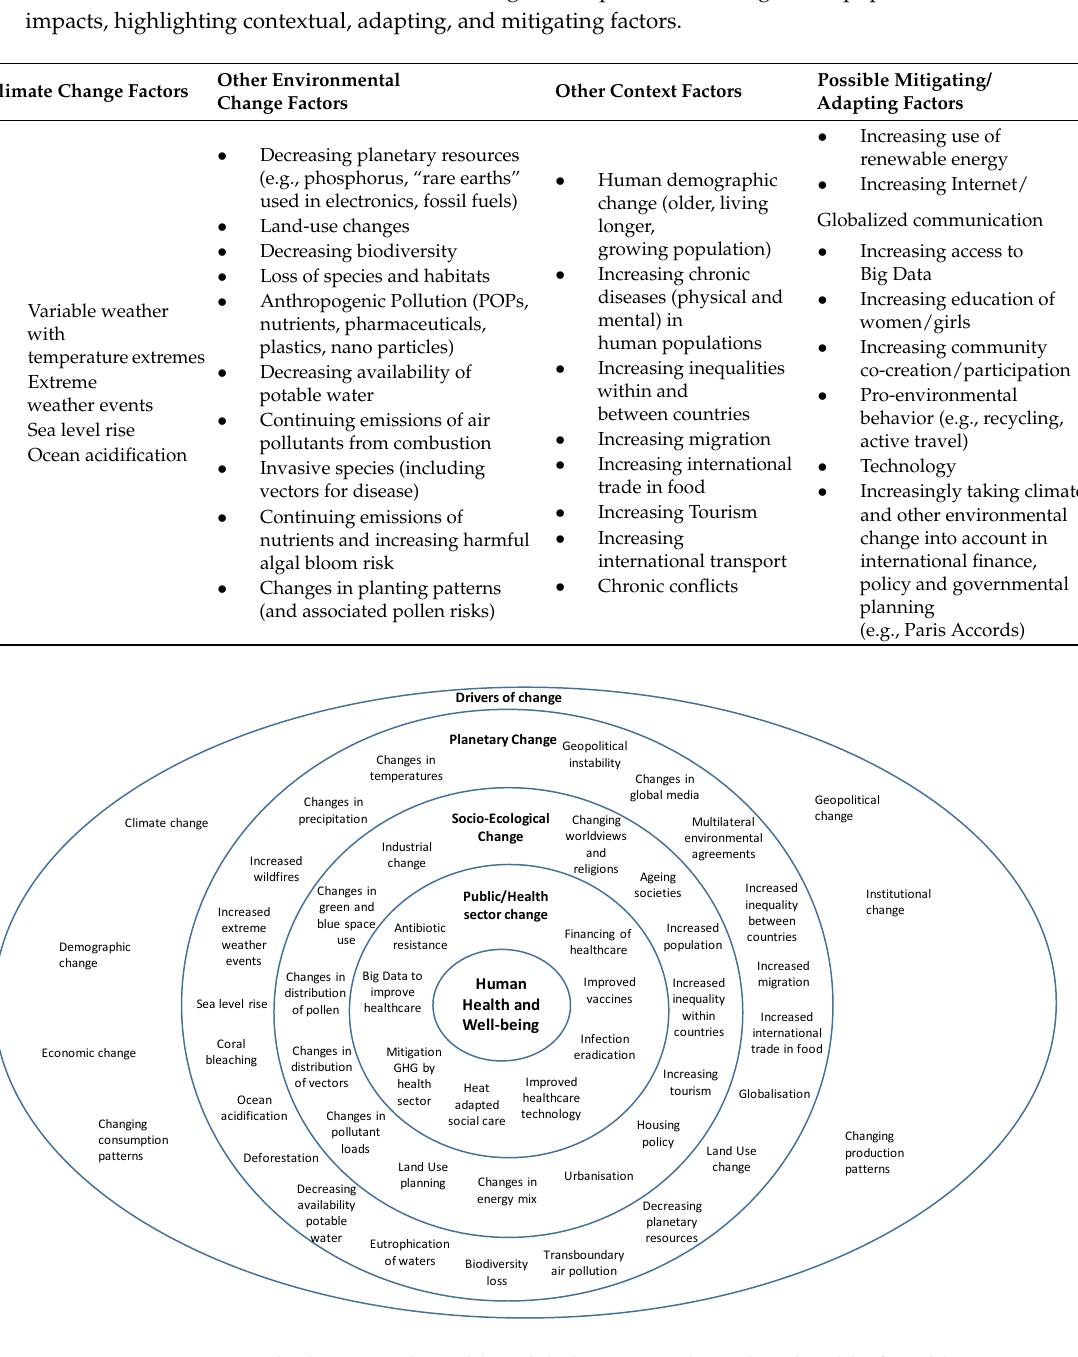
Table 1. Climate and other environmental changes with potential for large scale population health impacts, highlighting contextual, adapting, and mitigating factors.